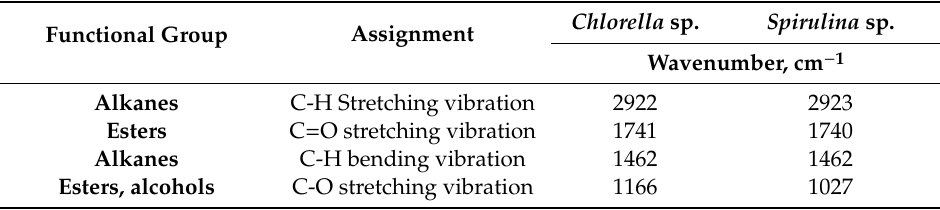
Table 3. Bands assignment of FTIR spectra for both species of